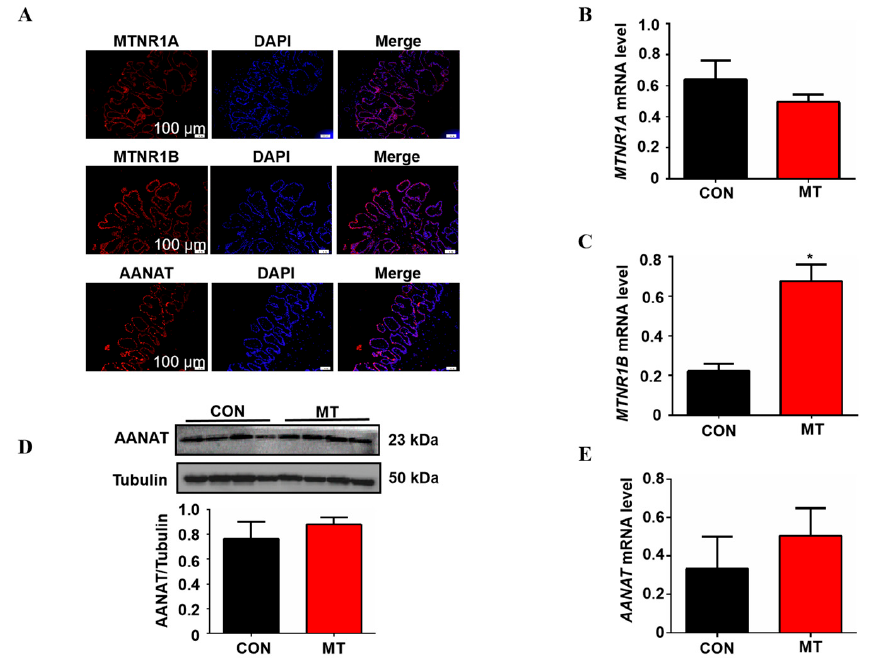
Figure 4. Detection of the melatonergic system in placental tissue of sows and effects of melatonin supplementation on it. ( A ) Location of MTNR1A, MTNR1B and AANAT in placental tissue. ( B , C ) The mRNA expression levels of MTNR1A and MTNR1B ( n = 5). ( D ) The protein expression level of AANAT ( n = 4). ( E ) The mRNA expression levels of AANAT ( n = 5). Data are presented as means ± SEM. * p < 0.05. CON = control, MT = melatonin.